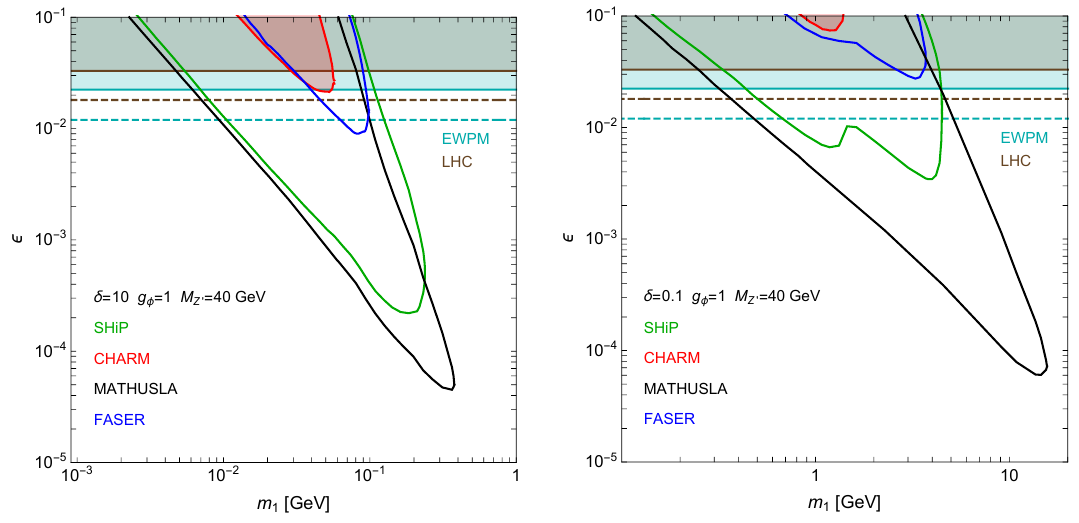
Figure 6 . 90% CL projected sensitivities (for SHiP, MATHUSLA and FASER) and exclusion limits (for CHARM) for the scenario with a dark photon mediator discussed in section 4.2. The mass of the dark photon is taken M Z 0 = 40 GeV, and the sensitivity reaches on the kinetic mixing parameter (cid:15) are shown as a function of the mass m 1 of the lightest dark scalar. Left (right) panel is for a mass splitting between the dark scalars of δ = 10 ( δ = 0 . 1 ). Cyan and gray regions are excluded by EWPM and LHC searches discussed in section 4.2. Dotted cyan and gray lines show the expected improvement of such